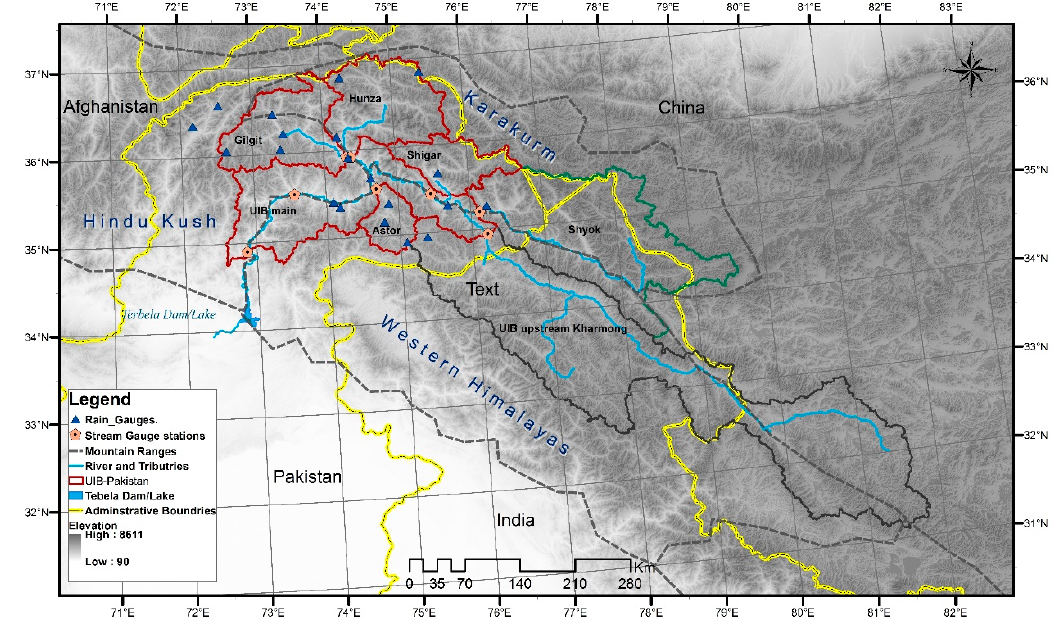
Figure 1. Upper Indus Basin (UIB): = Main sub-basins, network of hydro-meteorological stations, and boundaries of mountain ranges and streams and tributaries of the upper Indus.